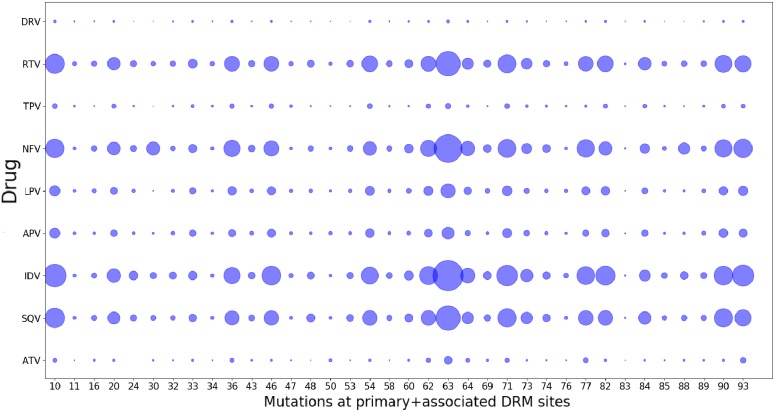
Drug-pressure associated mutations are largely common between drugs of the same class.The mutations (both primary and associated) arising in drug-treated HIV proteases in response to inhibitor treatment are shown corresponding to each protease drug. The diameters of the circles represent the number of mutations at that site that occurred in sequences treated with the particular drug. Most mutations that occur in response to one drug are seen to have occurred when treated with another drug of the same class, showing that the ‘spurious correlations’ (that could be picked up by a Potts model built on a mixture of patient sequences treated with different drugs of the same class, if the mutations occurring in response to one drug are not at all observed in response to another), are minimal.